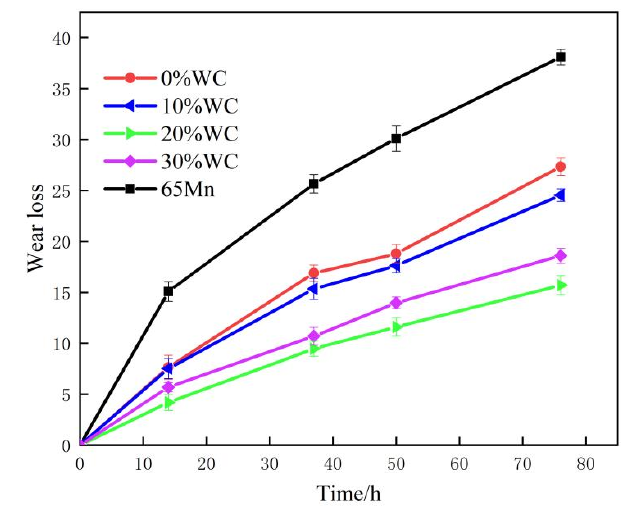
Figure 9. Comparison of wear loss in field tests.